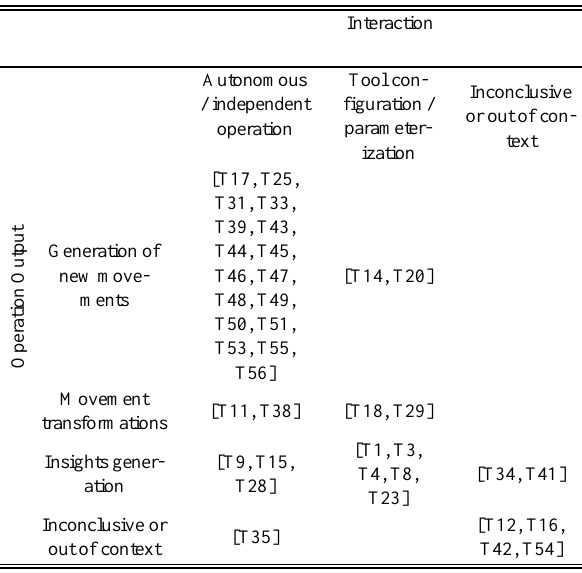
Table 4. Categorization of excluded technologies. Source: The au-